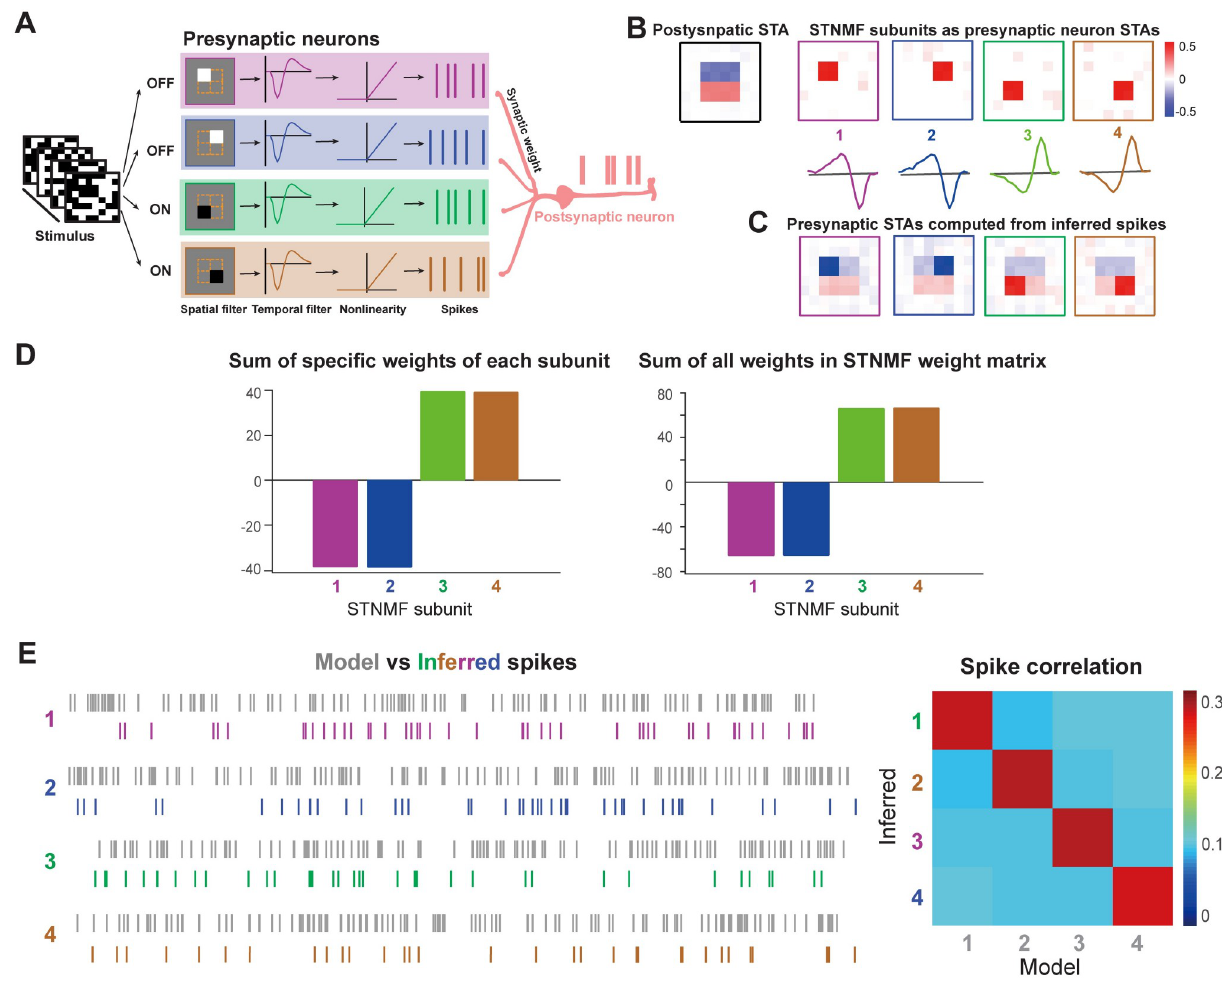
Fig 5. Mixture of ON and OFF cell types identified by STNMF. (A) Illustration of a neural network with ON and OFF cells. Similar to Fig 1, except that there are both ON and OFF presynaptic neurons. (B) ON and OFF cells are separated from STNMF. The RF of the postsynaptic neuron computed by STA (left). RFs of presynaptic neurons identified as STNMF subunits (top) with their corresponding temporal filters (bottom). (C) Presynaptic RFs computed by spikes inferred from STNMF. (D) Using STNMF weight matrix to classify spikes, the relationship among spikes, weights, and subunits is established, seen from (left) sum of specific weights of each subunit, and (right) sum all weights in each column of the weight matrix. (E) Spikes from the model and inferred by STNMF (left), and the corresponding matrices of spike